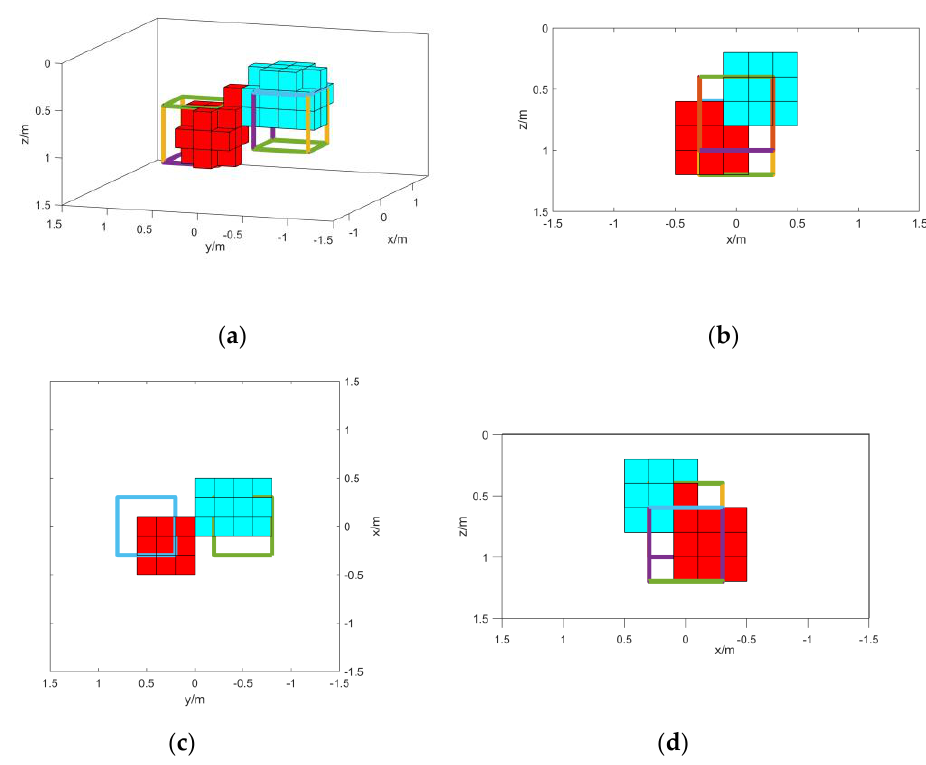
Figure 7. ( a ) Method 2 inversion results; ( b ) right-side view of method 2 inversion results; ( c ) top view of method 2 inversion results; ( d ) left-side view of method 2 inversion results.